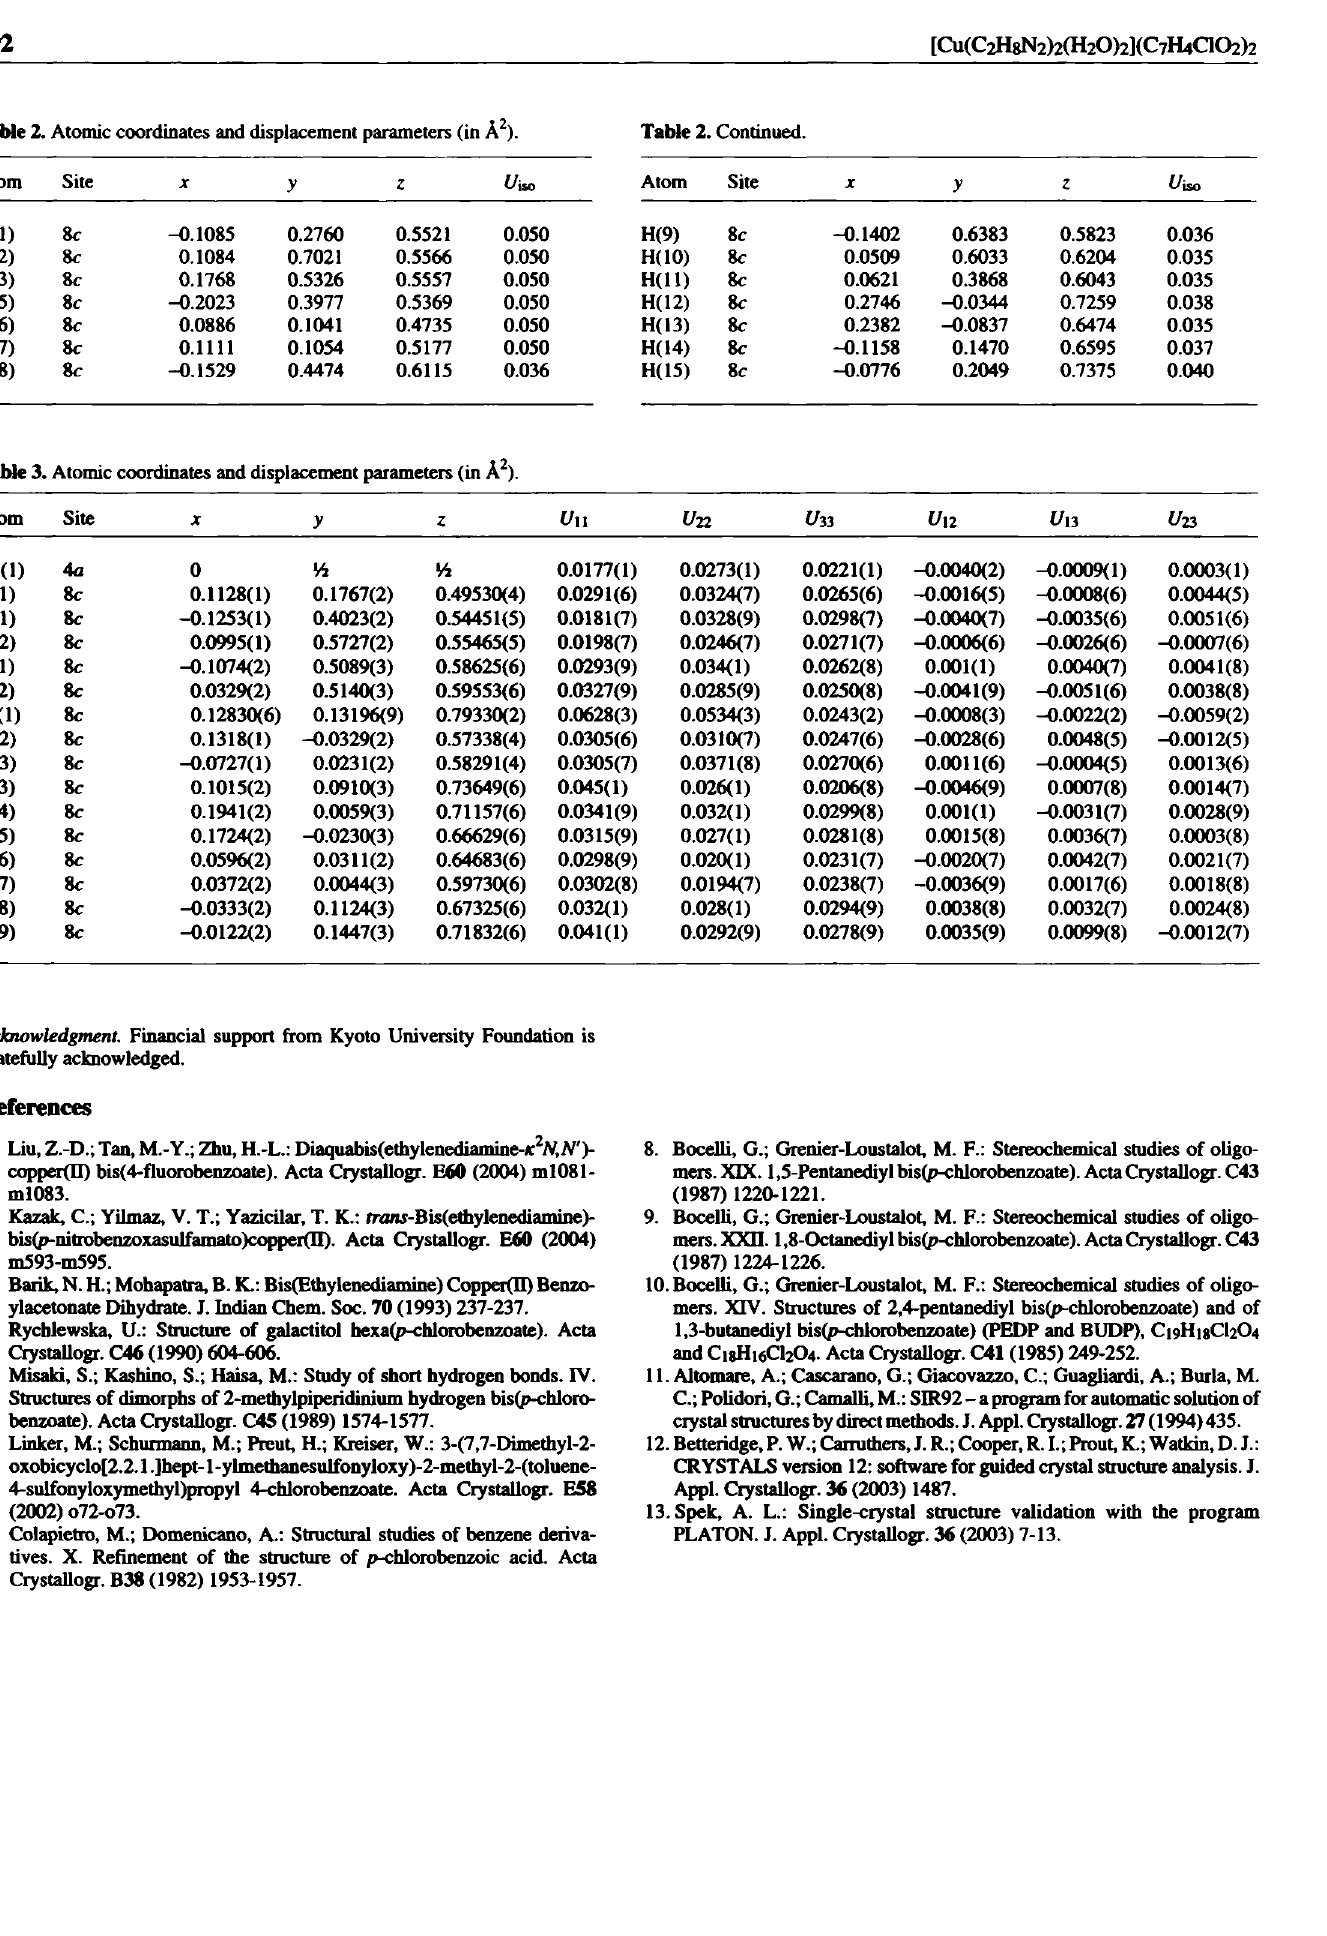
Table 2. Atomic coordinates and displacement parameters (in Ä 2 ). Table 2. Continued.